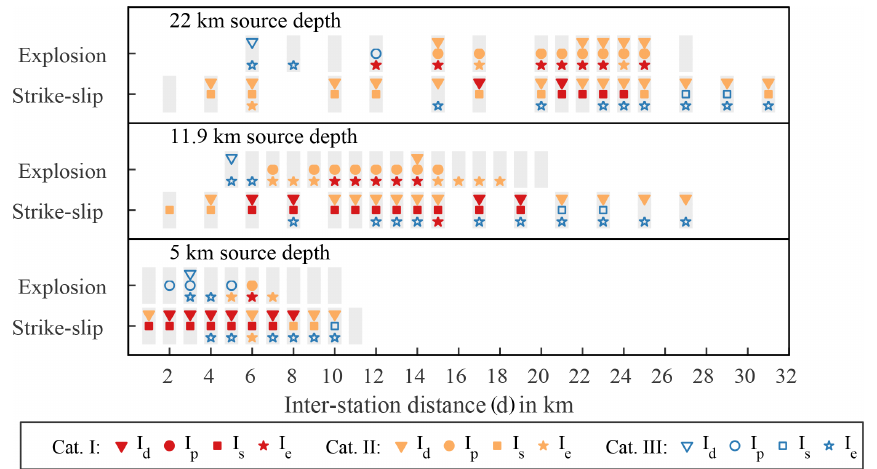
Figure 4. The location accuracy achieved with different inter-station distances ( d ). Three source depths were tested for the two source types, respectively. The location accuracies achieved with the individual imaging conditions were ranked according to the categories from Fig. 2. Grey bars indicate set-ups that were tested. No symbol in the grey bar means that the location was unsuccessful. Symbol types and colours in the grey bars represent successful locations with the imaging condition sorted into the respective category.